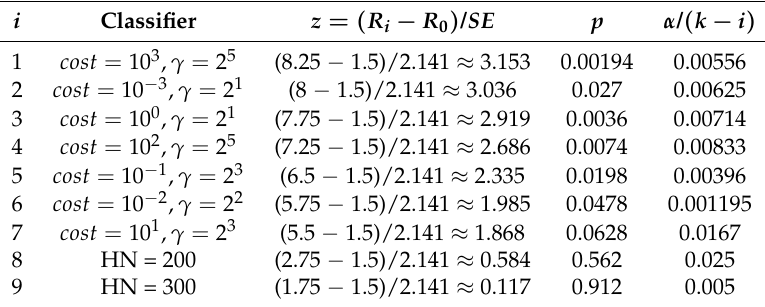
Table 14. Holm test of the training